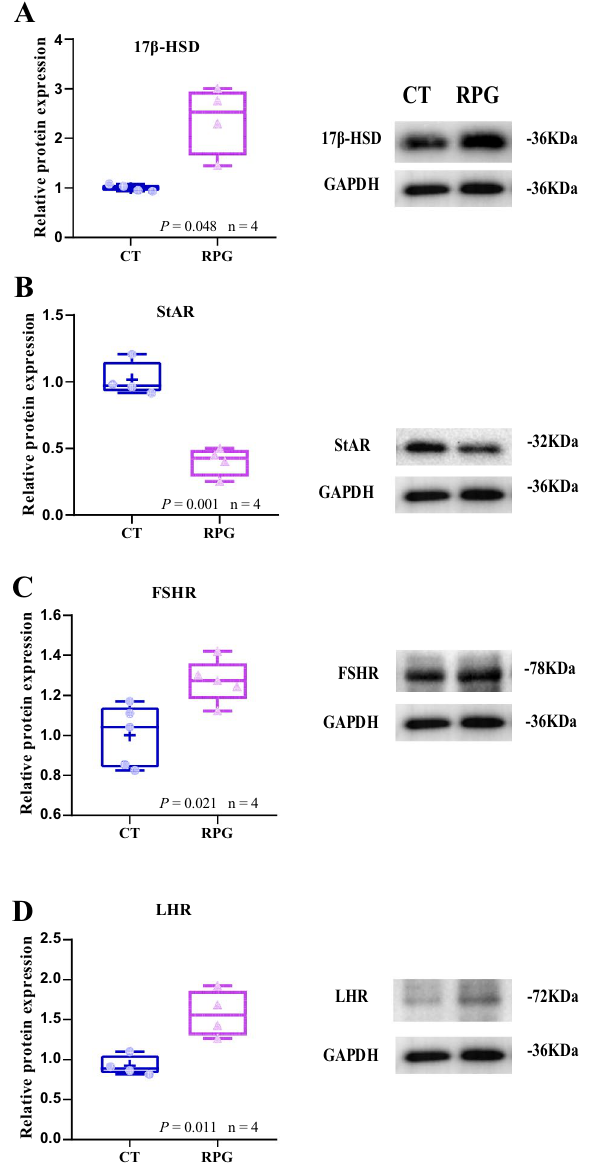
Figure 5. Box and whisker plots of the protein expression of ( A ) 17 β-HSD, ( B ) StAR, ( C ) FSHR, ( D ) LHR, ( E ) ERα, ( F ) ERβ, and ( G ) CYP17A1 in ovarian tissue from postpartum dairy cows show significant ( P < 0.05) between control diet and rumen-protected glucose diet. Figure 5 of the original blots/gels is presented in Supplementary Fig.